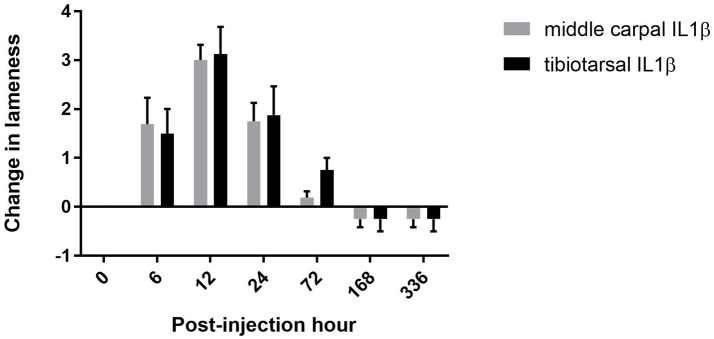
Change in subjective lameness score. There was no difference detected in the mean change of AAEP lameness scores when horses were administered rIL-1β in the MCJ or TTJ. Error bars represent the SEM.